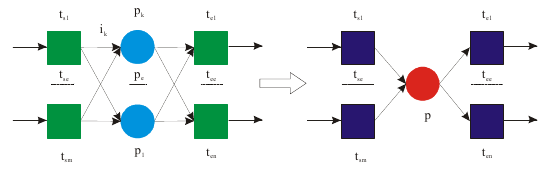
Fig.13. Overlapping places reduction rule